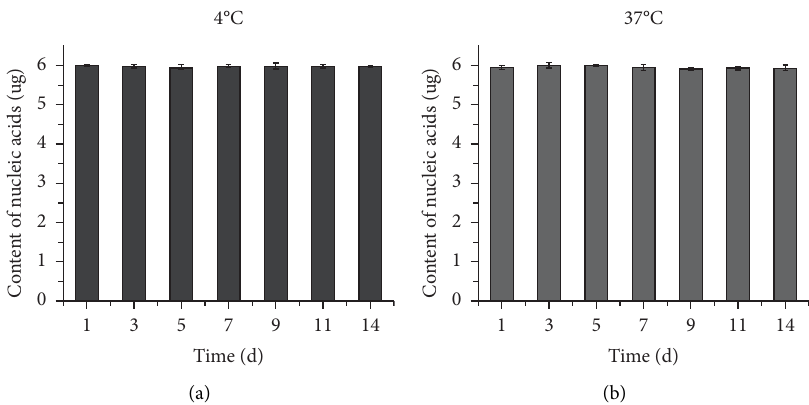
Figure 6: The short-term stability test of changes in 14 days of genomic nucleic acid reference material of C. sakazakii .